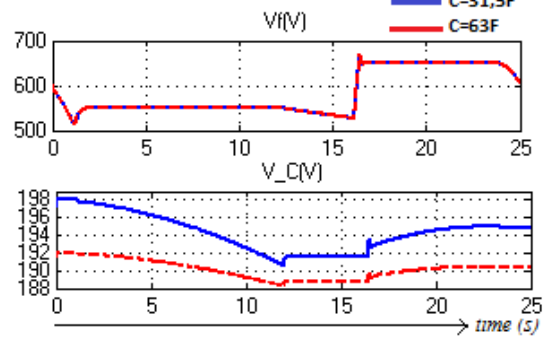
Fig. 21. Simulation diagrams of power for V SC = 198.15 V when C = 31.5 F and V SC = 192.06 V when C = 63 F in autonomous